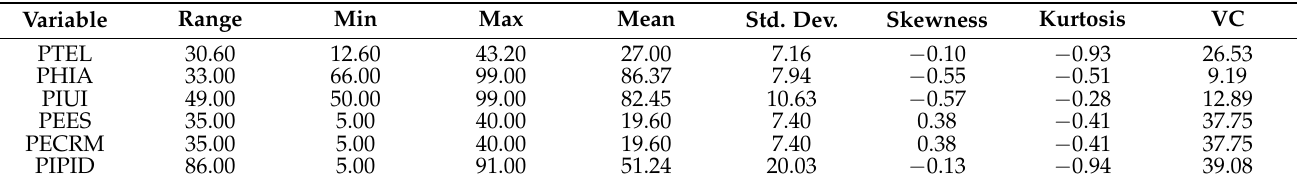
Table 3. Characteristics of the analysed